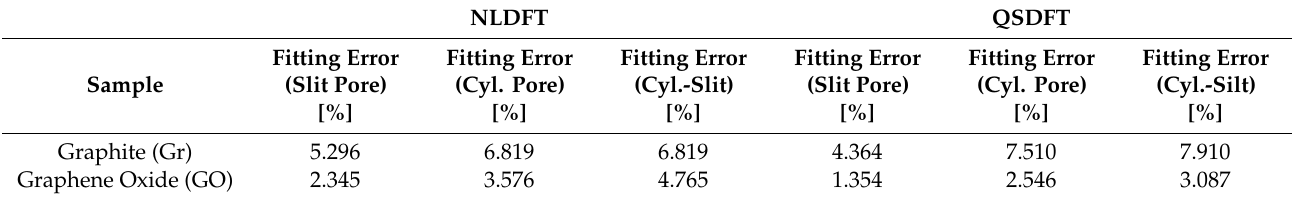
Table 2. Fitting error for di ff erent surface textures (NLDFT vs. QSDFT) in slit and slit / cylindrical